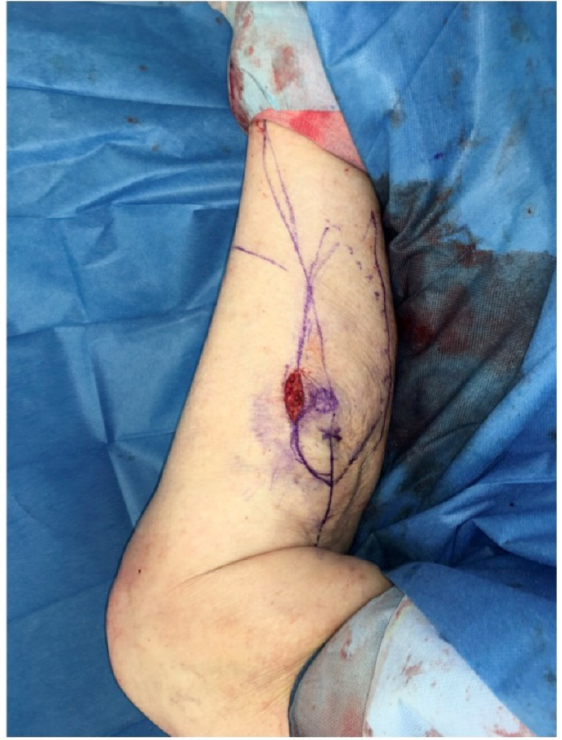
Figure 13: Pedicled MSAP gastrocnemius flap: Intraoperative drawing to raise the flap. The crosses indicate the skin perforators (identified with a Doppler) over the medial gastrocnemius muscle. An anterior incision is performed to visualize and verify the perforator anatomy. The skin island is then designed around the perforators according to the soft-tissue defect (Table 1: Patient No. 5; additional Figures 6, 12, 14, 15, 16, 17).